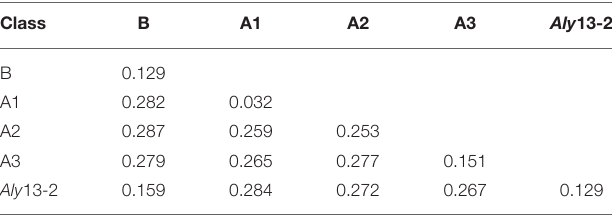
TABLE 3 | Percent sequence divergence within and between dominance classes, for alleles identified using 454 sequencing. Class